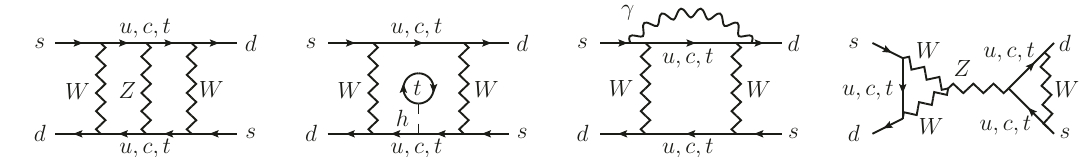
Figure 1 . Sample two-loop Feynman diagrams contributing to the initial condition of C 00 tt